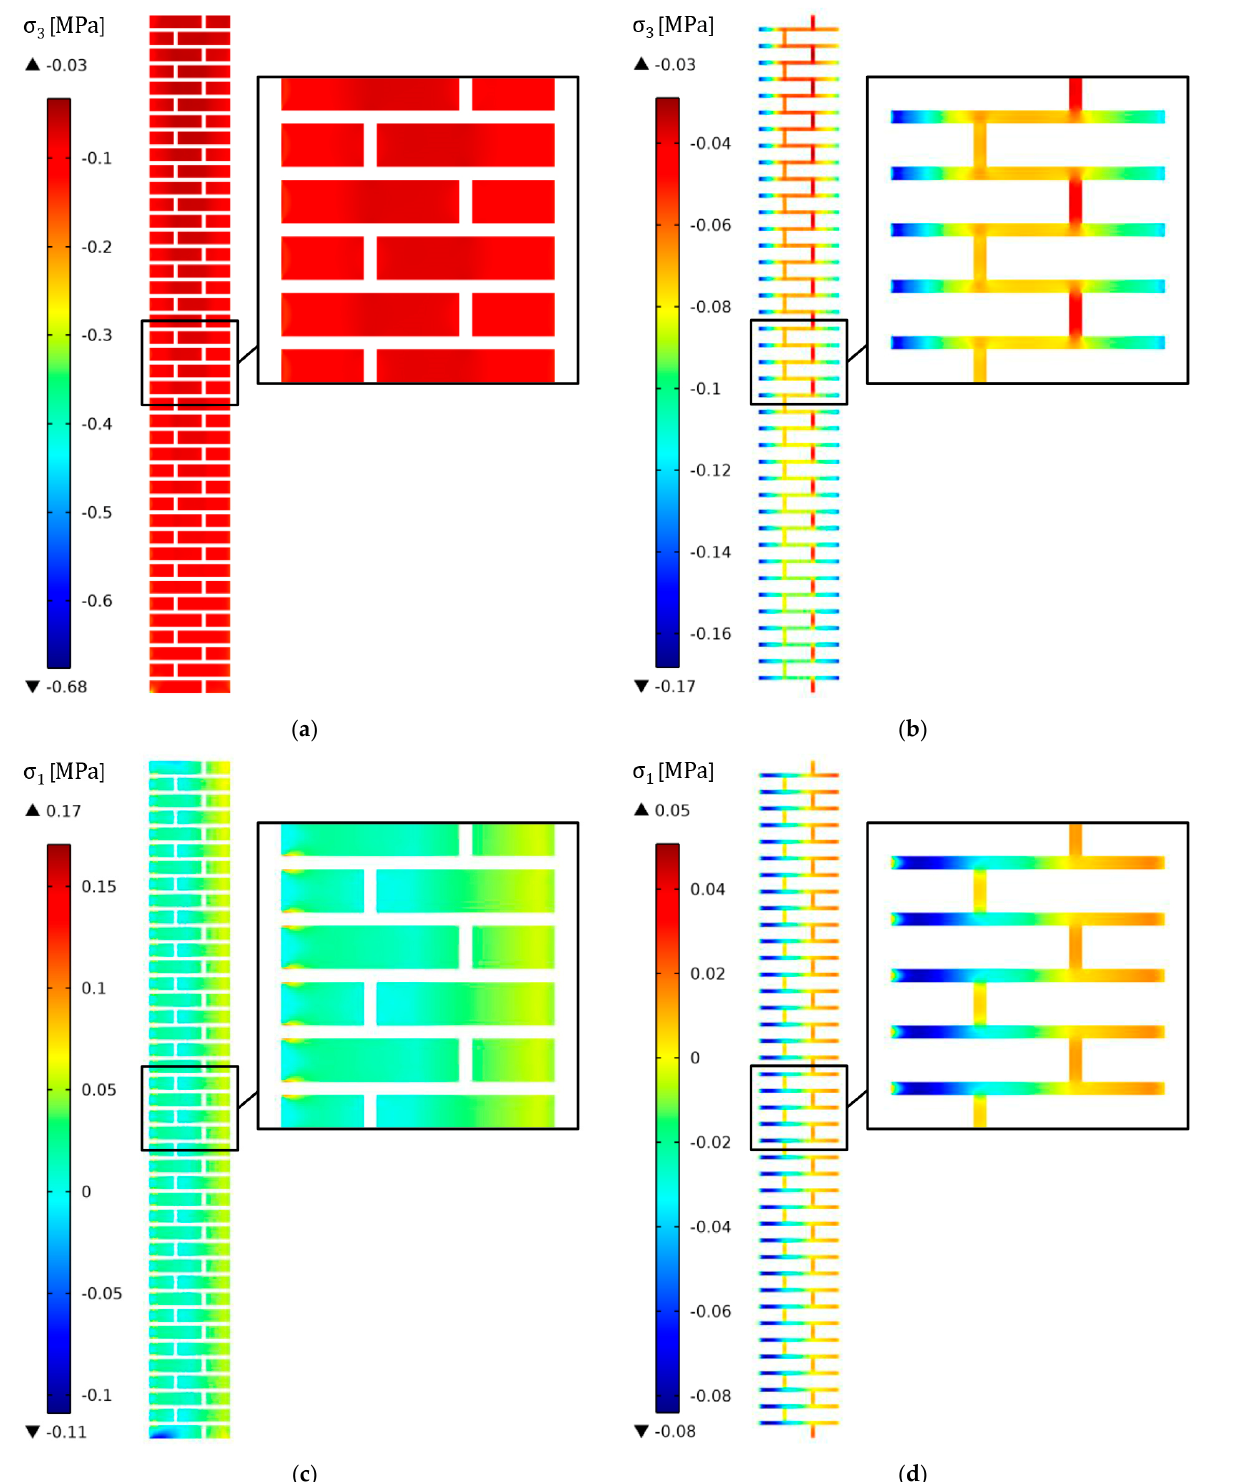
Figure 15. Hygro-thermo-mechanical analysis of the three-wythe brick masonry wall with cement mortar. Principal stress distribution obtained for the hygro-thermo-mechanical case: minimum principal stress, σ 3 [MPa], in ( a ) bricks and ( b ) mortar joints; maximum principal stress, σ 1 [MPa], in ( c ) bricks and ( d ) mortar joints.